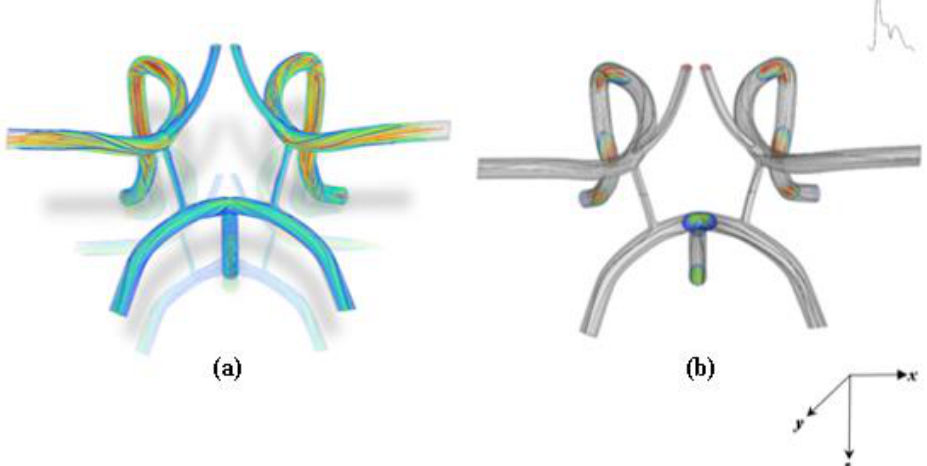
Figure 1. Flow characteristic profile inside the CoW: ( a ) Streamline traces of blood flow and ( b ) plot segments of velocity contour and streamlines during systole (5th cardiac cycle).